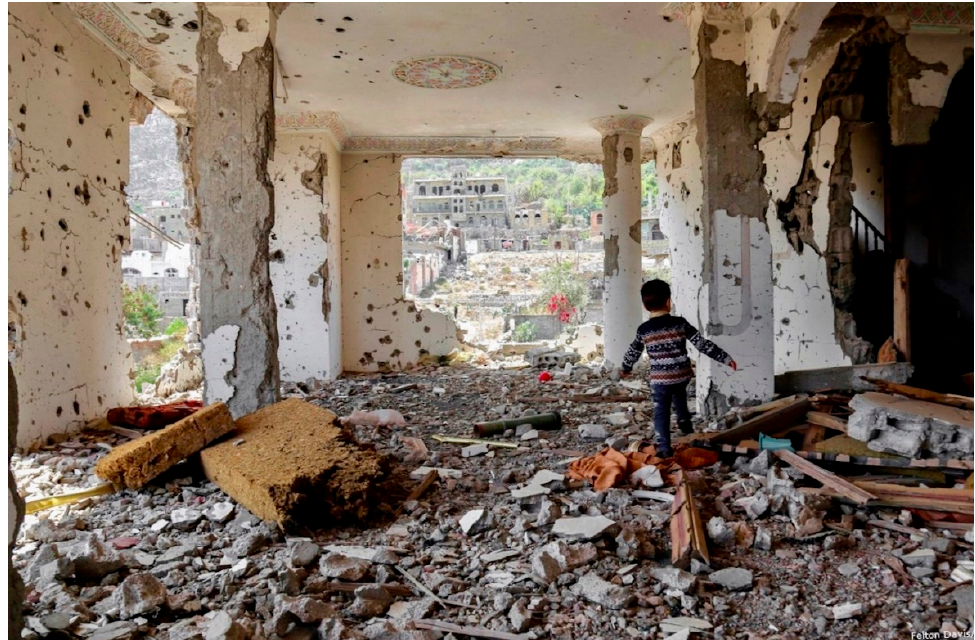
Figure 16. Yemeni child walks though rubble from Saudi/Emirati airstrike on Sana’a; photo credit Felton Davis/Flickr.